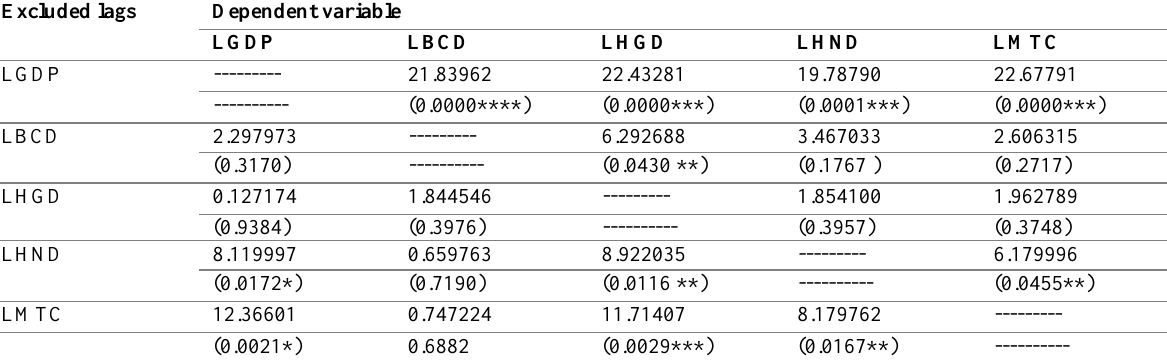
Table 8: Causation results